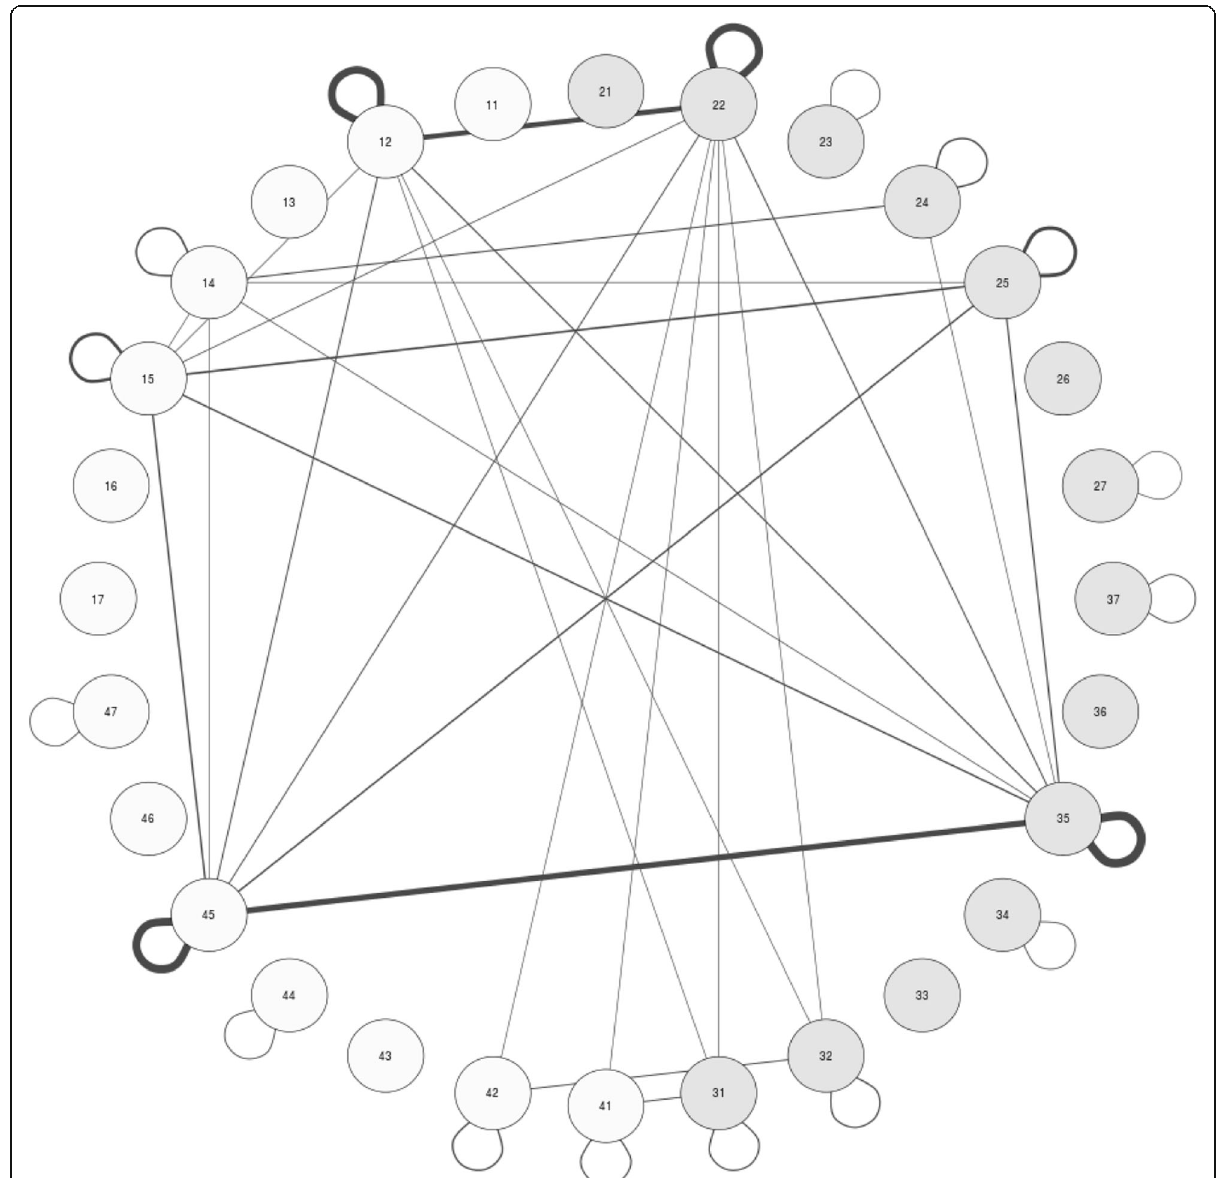
Fig. 2 Network graph representing the two dental arches. Each tooth is represented by a node. Missing teeth in more than 5 patients are marked with a green ring: the thicker the ring is, the higher the frequency of agenesis for that tooth. Teeth which presented simultaneous agenesis are connected to each other: the thicker the line, the higher the frequency for that pair of